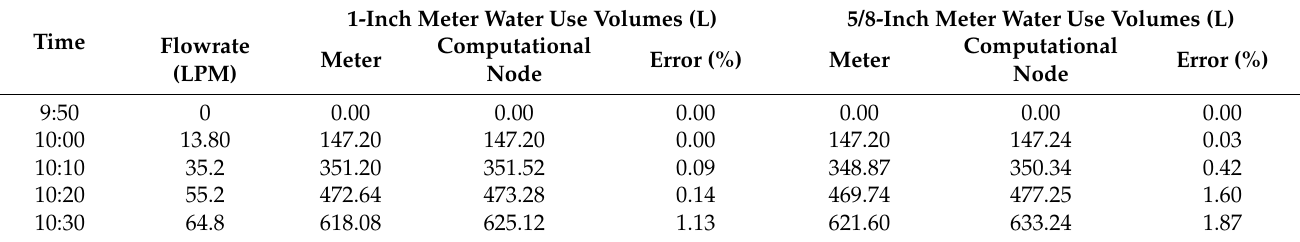
Table 8. Results from laboratory experiment 2 for the 1-inch and 5/8-inch Master Meters.